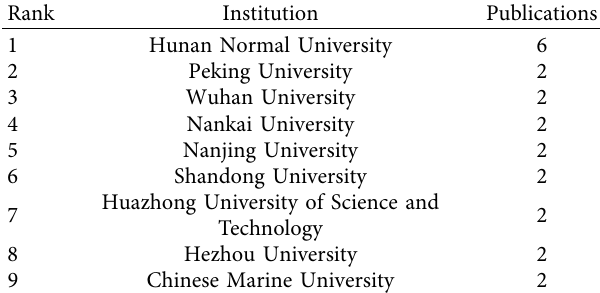
Table 2: Top 9 institutions based on